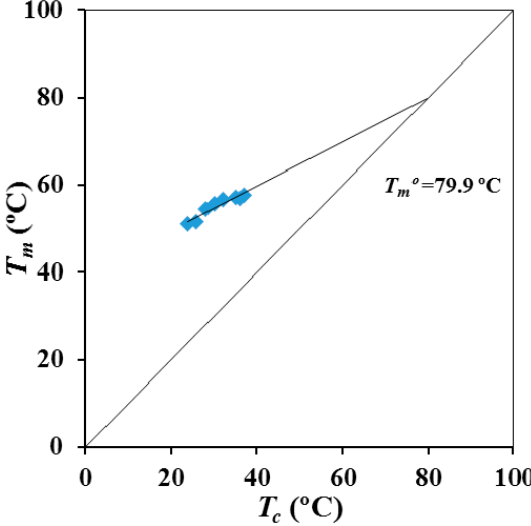
Figure 5. Ho ff man-Weeks plot for P4HB considering the temperatures of its first melting Figure 5. Hoffman-Weeks plot for P4HB considering the temperatures of its first melting peak.